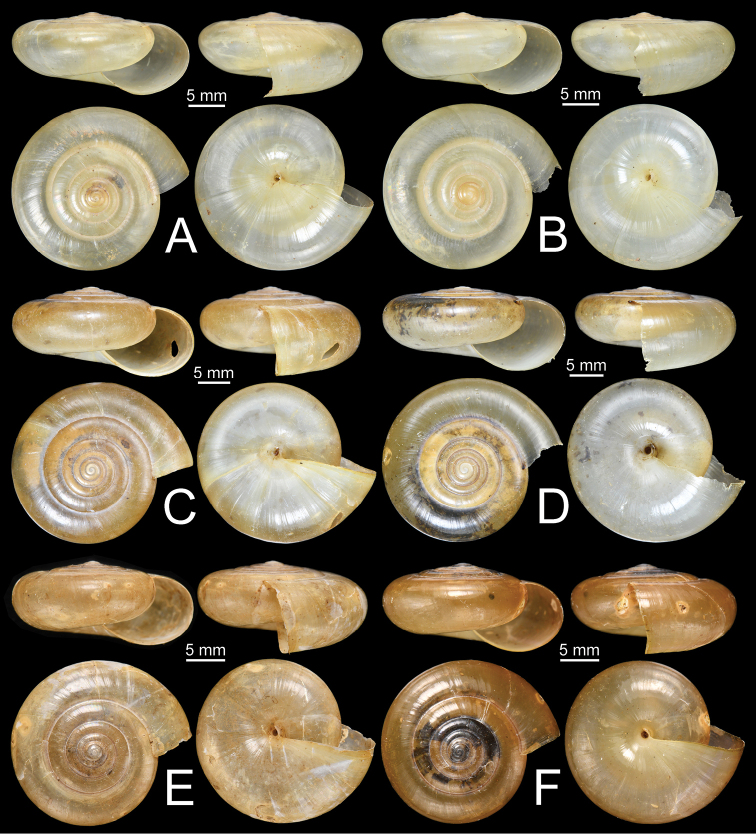
Shells of Group II: Sarika
hainesi group. A, BSarika
inferospira sp. nov. A holotype CUMZ 7254 and B paratype CUMZ 7255 C, DS.
melanospira sp. nov. C holotype CUMZ 7258 and D paratype CUMZ 7243 E, FS.
pellosa sp. nov. E holotype CUMZ 7249 and F paratype CUMZ 7517.